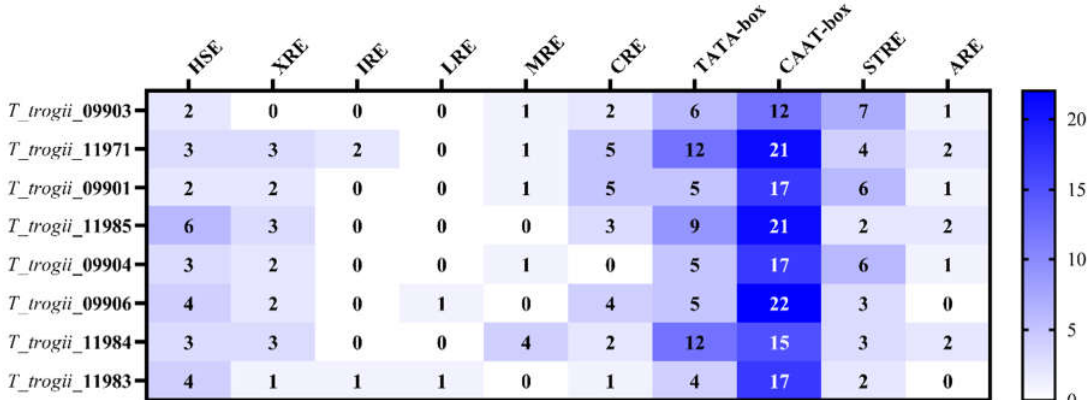
Figure 4. The number and the kind of the putitive responsive elements in the promoter regions of TtMnPs. Typical nucle- otide sequences for each putative responsive element are as follows: HSE: GAANNTTC; XRE2:CACGCT XRE2:CACGCA;